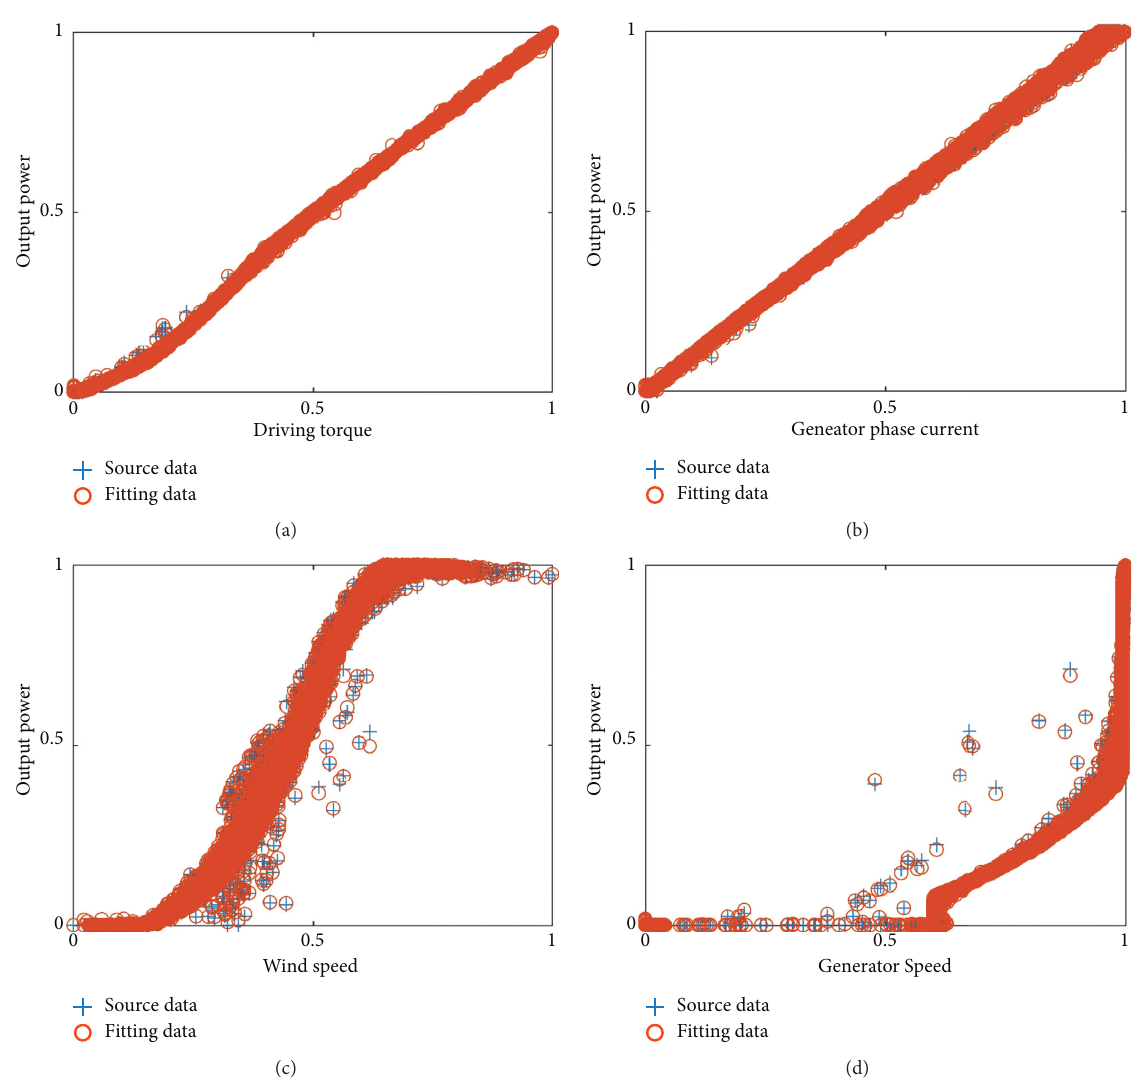
Figure 3: Comparison between the source SCADA data and regression prediction results: (a) rotation torque, (b) generator current, (c) average wind speed in 10 min, and (d) generator